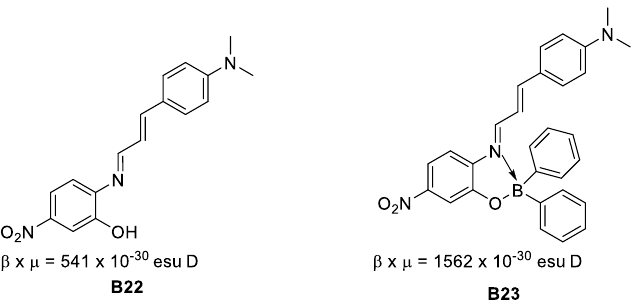
Figure 17. Hyperpolarizability response after boron complexation.